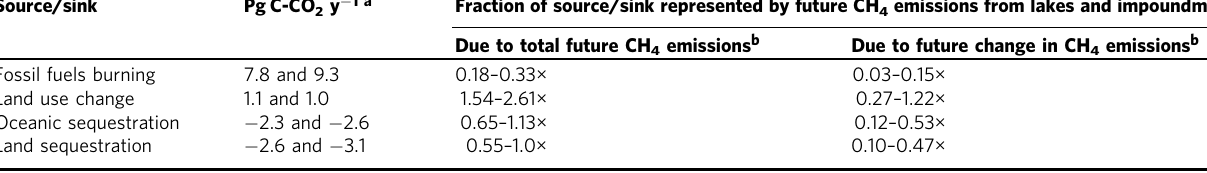
Table 2 Projected increases in CH 4 emissions from lakes and impoundments as compared to major global CO 2 sources and sinks